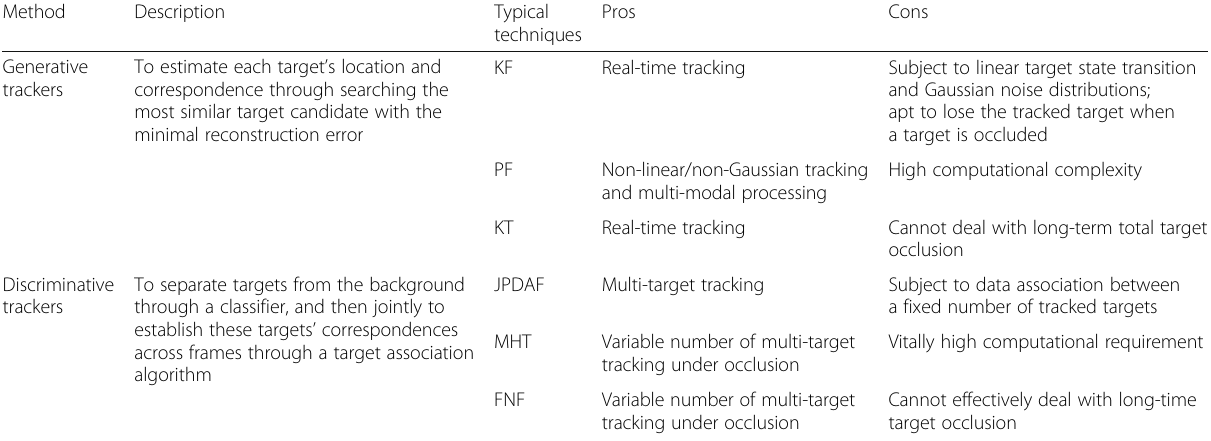
Table 1 Human tracking algorithms within a camera Method Description